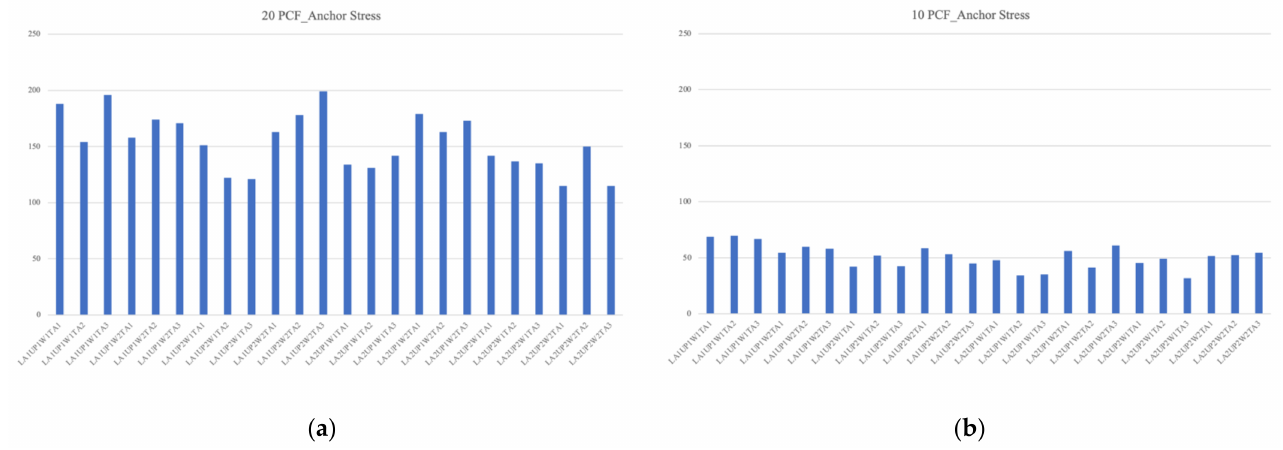
Figure 9. Comparison of the stress on anchor of 24 groups in ( a ) 20 PCF and ( b ) 10 PCF.